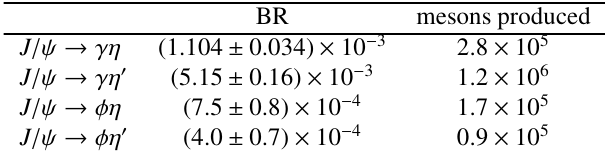
Table 1. Branching ratios of the radiative and hadronic J /ψ decays [4] used to tag η and η (cid:2) meson production at BESIII, and the number of produced mesons in a data sample of 225 . 3 × 10 6 reconstructed J /ψ